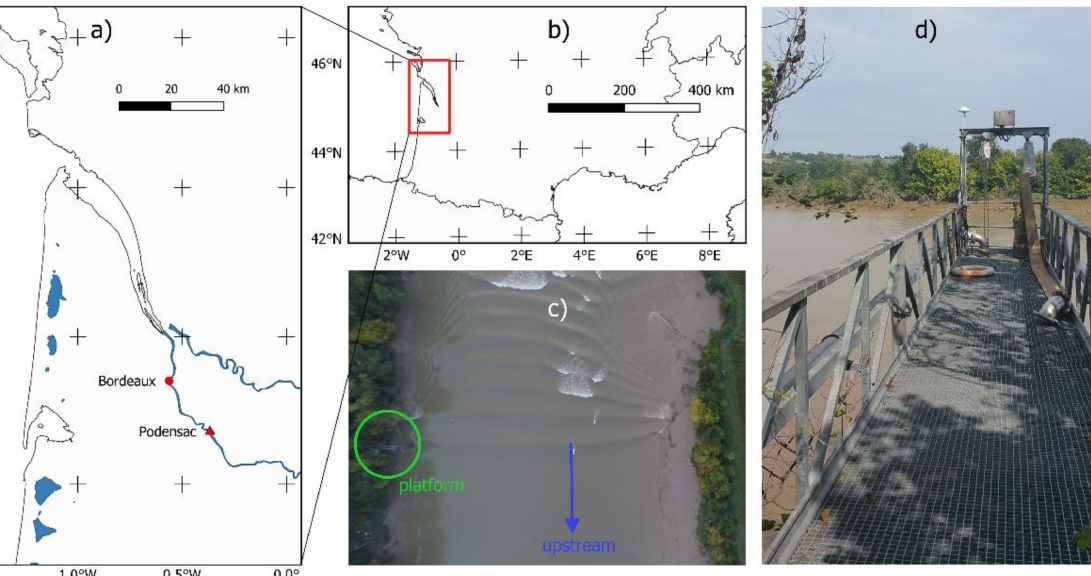
Figure 1. Location of the study area. ( a ) Location of Podensac on the Garonne River; ( b ) the Gironde/Garonne/Dordogne estuary in southwest France; ( c ) drone image of the Garonne River taken by V. Marie (EPOC), showing the first waves of the tidal bore, its direction of propagation, and the platform location; ( d ) photo of the Garonne River from the platform with the GNSS antenna installed. The narrowness of the river and the vegetation on riverbanks are visible in both